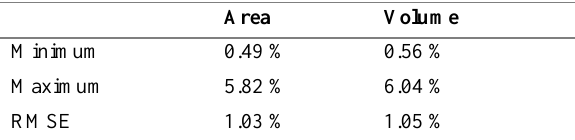
Table 3. Accuracy assessment of the computed goose bump area and goose bump volume